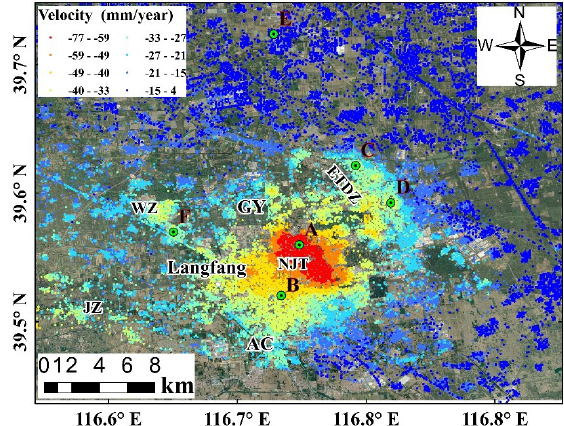
Figure 4. Average subsidence rate in the study area during the period from 2007 to 2010